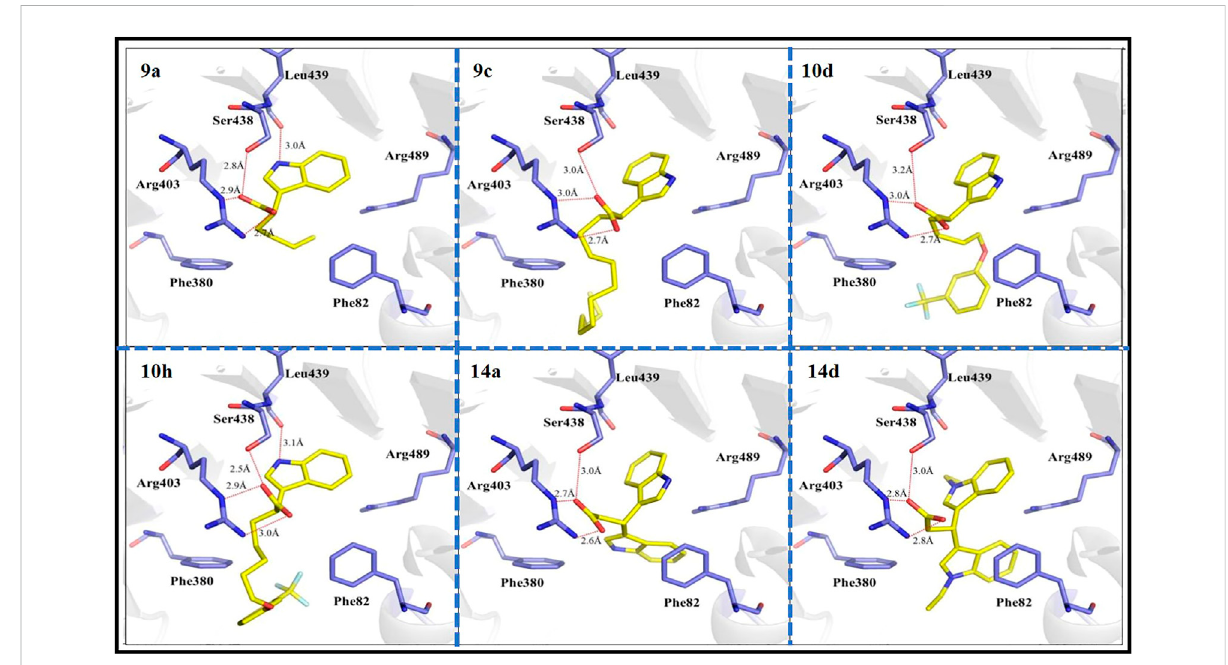
FIGURE 5 Binding modes of compounds 9a, 9c, 10d, 10h, 14a, and 14d with TIR1 (PDB code 2P1Q) at the active site. The key residues of active sites were represented by blue sticks, and the target compounds are represented by yellow sticks. The oxygen atoms are shown in red, the nitrogen atoms are shown in blue, and the fl uorine atoms are shown in light